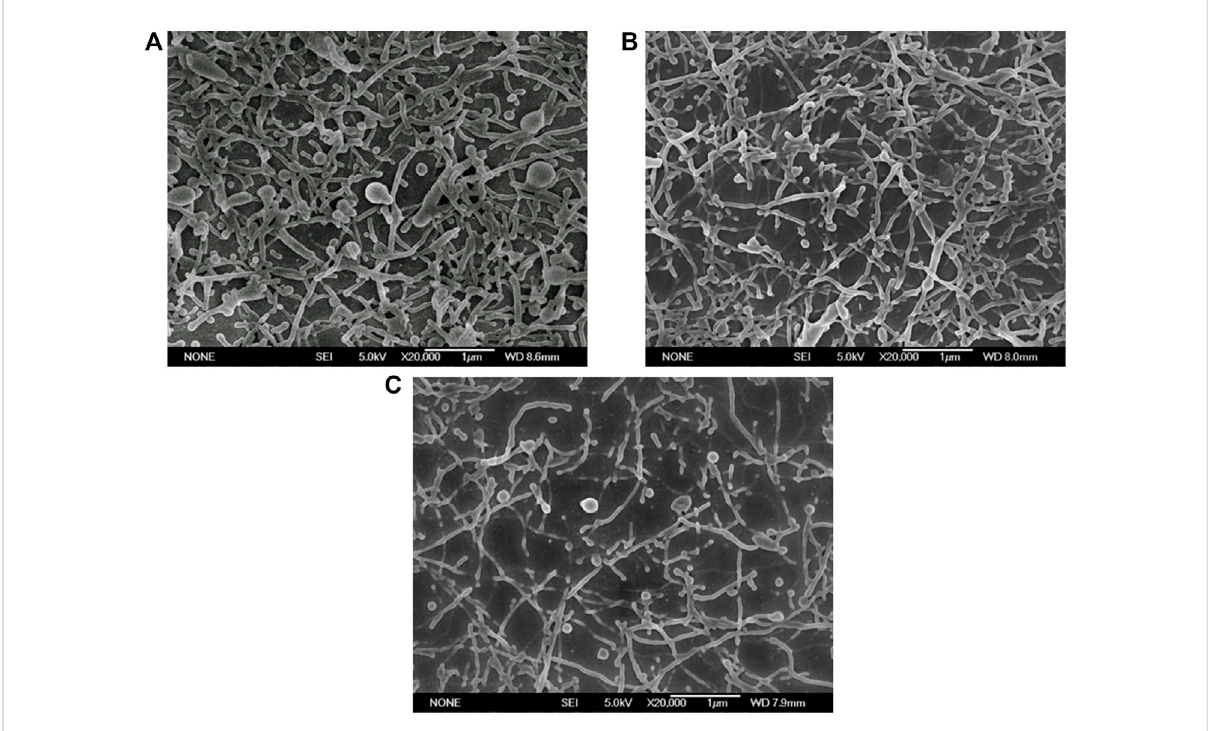
FIGURE 7 Electron micrographs of PLGA nanoparticles prepared with different high PVA concentrations (Scale bar: 1 μ m) (A) 1.0 wt%; (B) 2.0 wt%; (C) 3.0